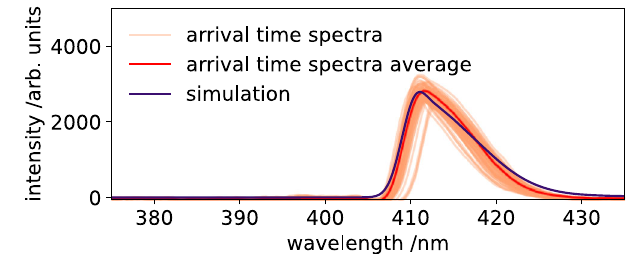
Fig.9|Comparisonofcalculatedarrivaltimespectra. Estimationofthetransient refractiveindexchangeindiamondintheactualexperiment.Thesolidbluecurveis a simulation which recreates the original experimental data with an X-ray-induced refractiveindexchangeof Δ n exp = (cid:2) 5 : 7×10 (cid:2) 5 .Thesolidorangecurveanumerical simulation.Theorangecurveisthesimulatedarrivaltimesignal,usingtheMaxwell- Garnett ( Δ n MG ) theory. The orange band gives the upper and lower expected transient refractive index change according to the Maxwell-Garnett model when implementingtheuncertaintyoftheX-raybeamfocalsizeof150±20 μ m.Thesame applies to the purple curve which indicates the calculated values for the same conditions but with the Drude model ( Δ n D